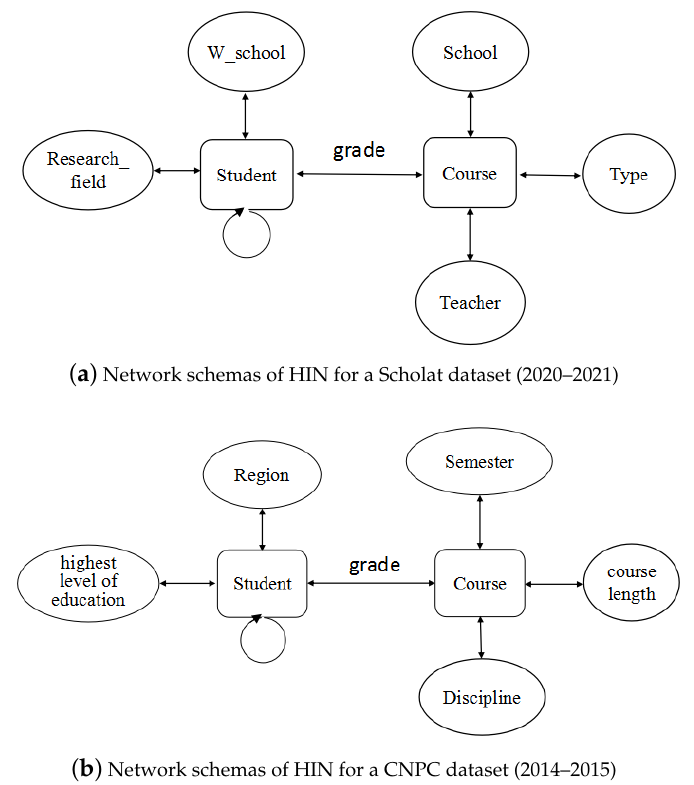
Figure 1. Network schemas of heterogeneous information networks for the two course